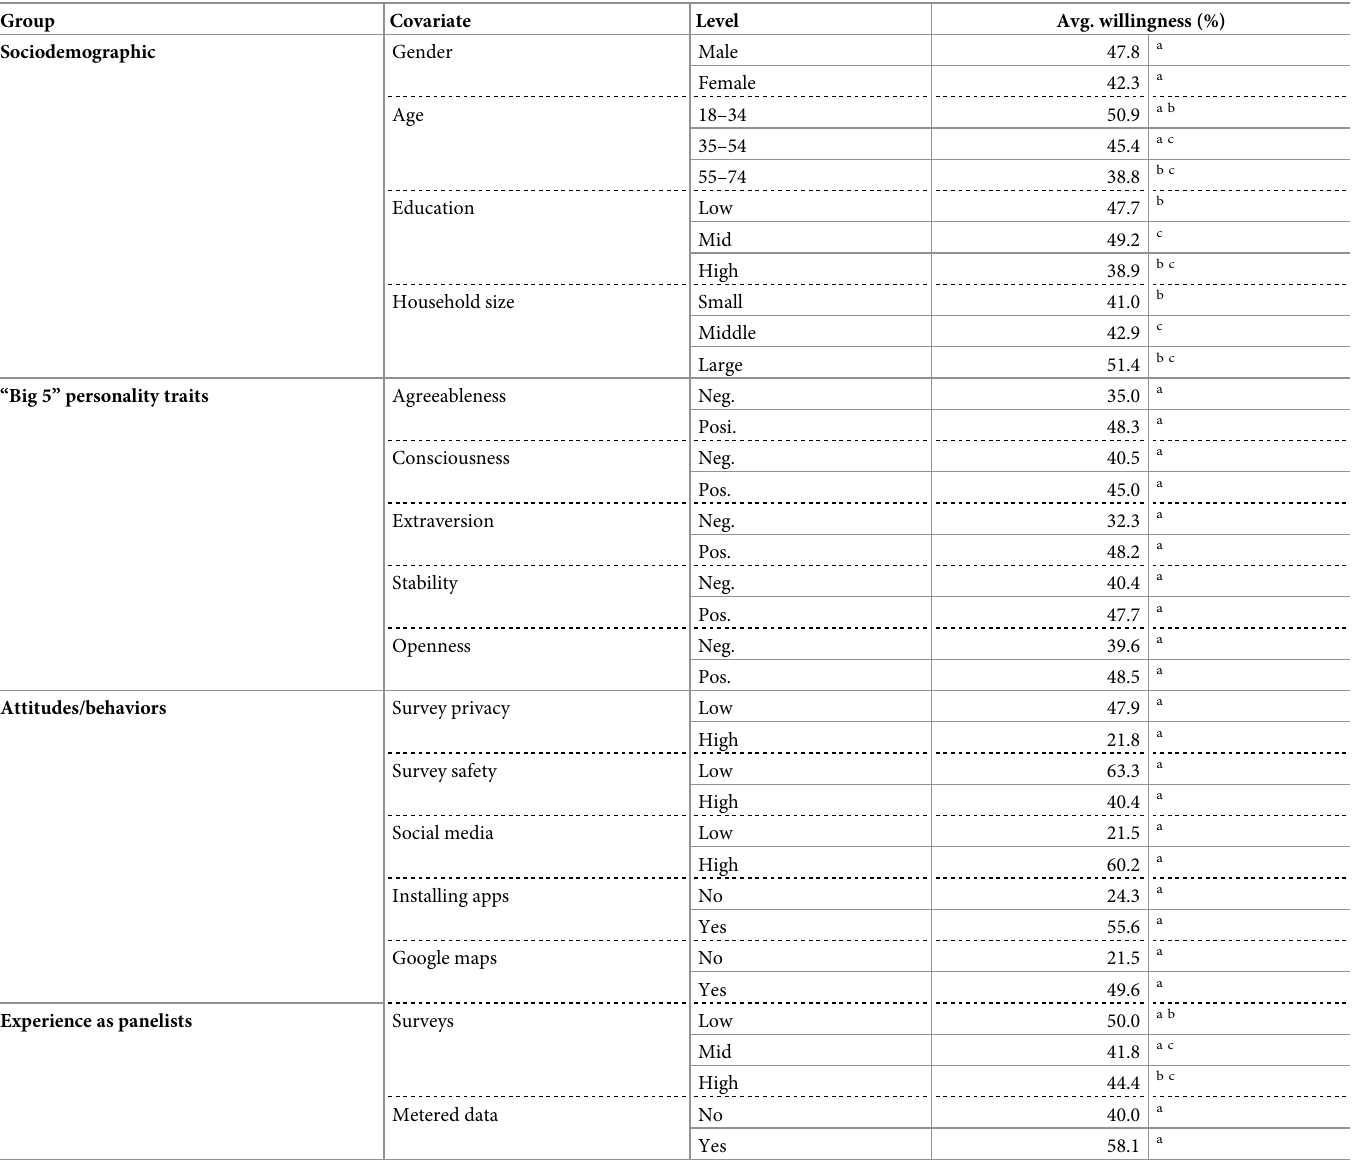
Table 4. Willingness to participate per group of